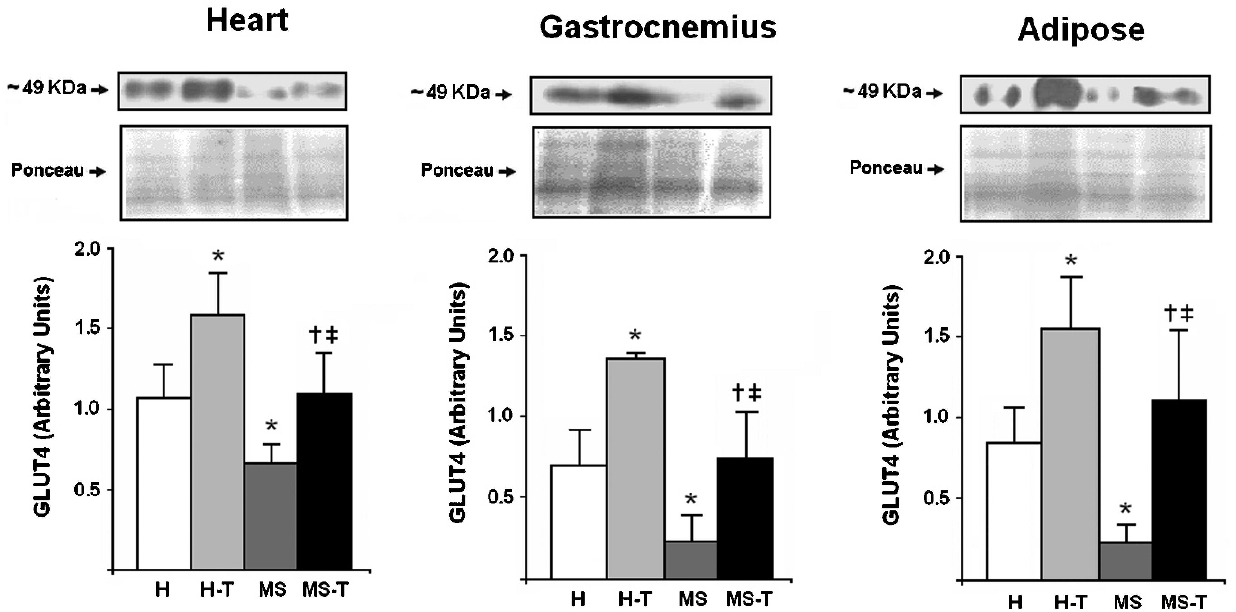
Figure 3 - GLUT4 protein content in the heart, gastrocnemius muscle and epididymal white adipose tissue. The top shows representative images of GLUT4 and the respective loading controls. The loading controls are the total proteins in the 35- to 130-kDa range of Ponceau-stained membranes, as described in the Methods section. The graphs on the bottom show the means ¡ SEM. H (n=5): sedentary spontaneously hypertensive rats; H-T (n=5): trained spontaneously hypertensive rats; MS (n=5): sedentary metabolic syndrome rats; MS-T (n=5): trained metabolic syndrome rats. Two-way ANOVA (Bonferroni’s post-hoc test). * p , 0.05 vs. H; { p , 0.05 vs. MS; { p , 0.05 vs. H-T.